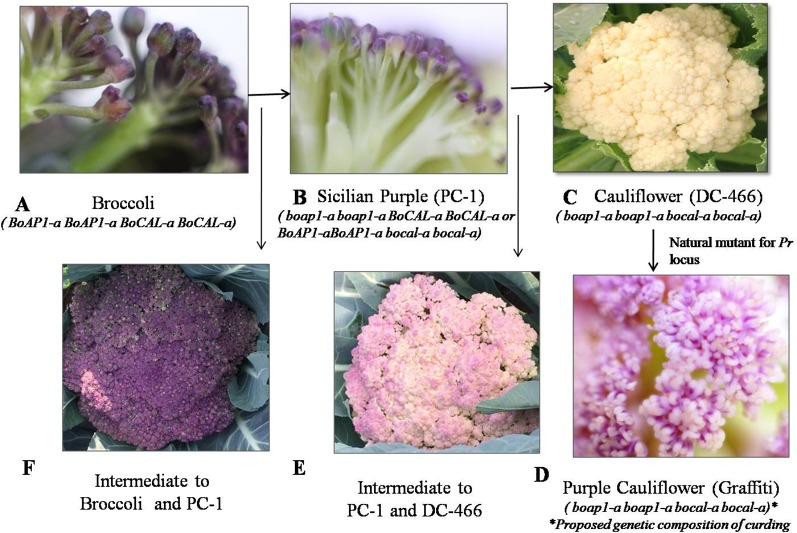
Flower buds in knob texture of curd/heads. Broccoli type (A), Sicilian purple ‘PC-1’ type (B) white cauliflower ‘DC-466’ (C), purple cauliflower ‘Graffiti’, (D) intermediate of ‘PC-1’ and ‘DC-466’ (E), Intermediate of ‘PC-1’ and broccoli (F).